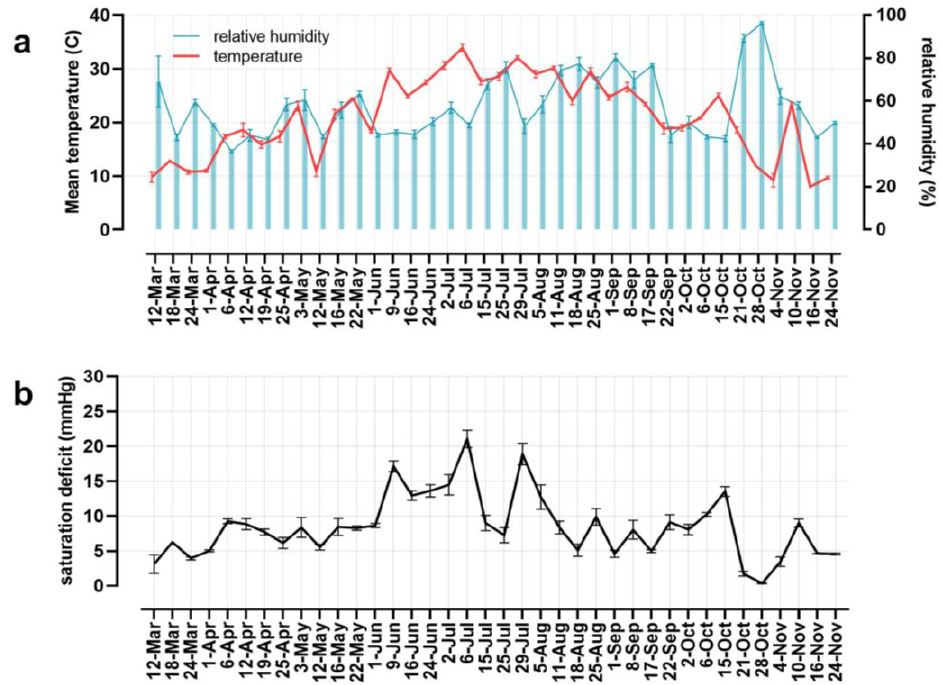
Figure 3. ( a ) Mean temperature and relative humidity calculated from the data registered in the weather station (Society Hill, NJ) at the start time of the tick sampling in each site (n = 5/day). ( b ) Saturation deficit calculated combining the data of temperature and relative humidity registered (more details in Materials and Methods).